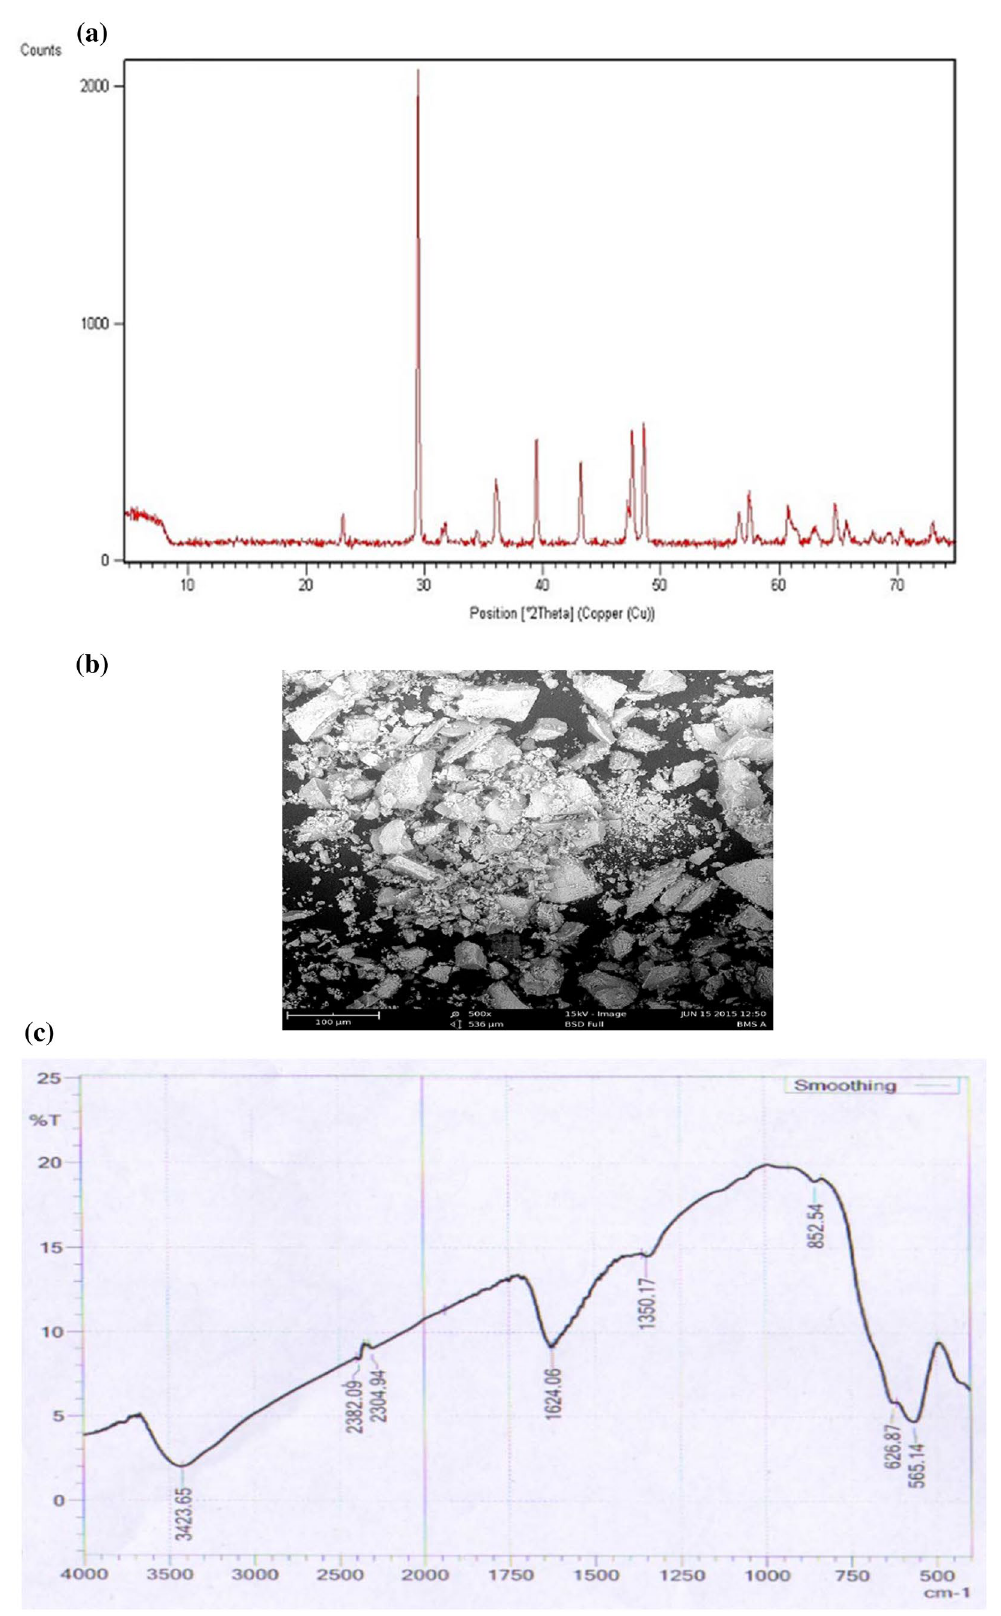
Fig. 1 a XRD image of synthesized magnetite (Fe 3 O 4 ). b The SEM image of synthesized of magnetite (Fe 3 O 4 ). c The FTIR image of synthesized magnetite (Fe 3 O 4